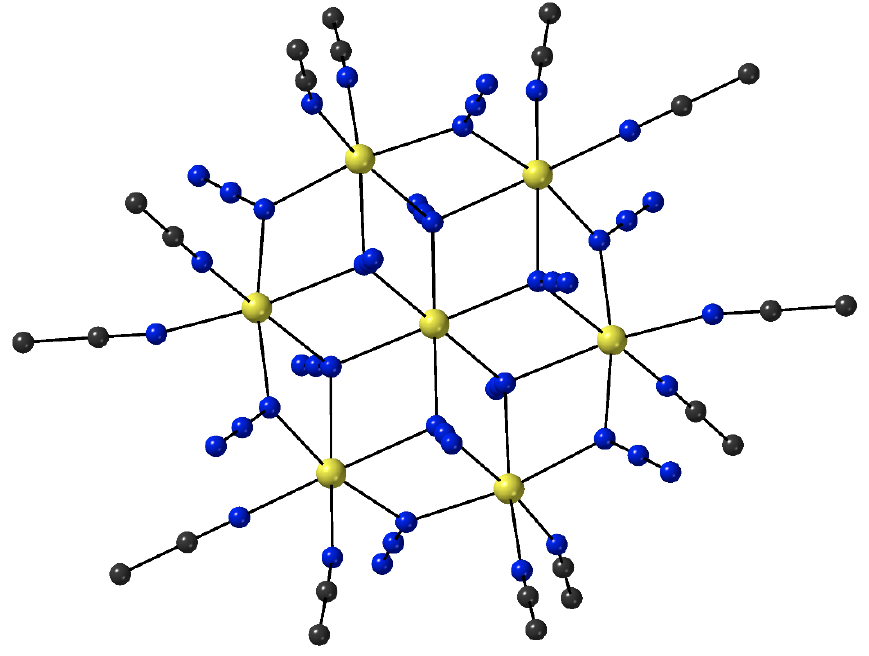
Figure 6. The molecular structure of the heptanuclear cation of cluster 7 · 4MeCN. The Fe II centers are shown with dark yellow color, the nitrogen atoms with blue color and the carbon atoms with black color. Modified from reference [31].